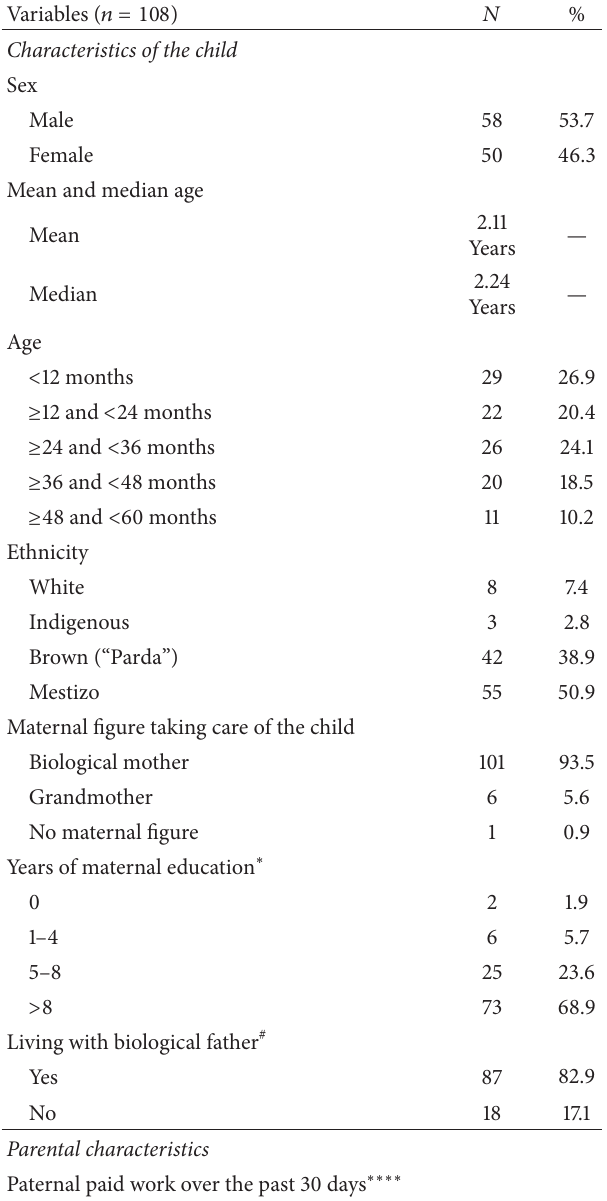
Table 1: Epidemiological characteristics of children aged under 5 years, I˜napari,